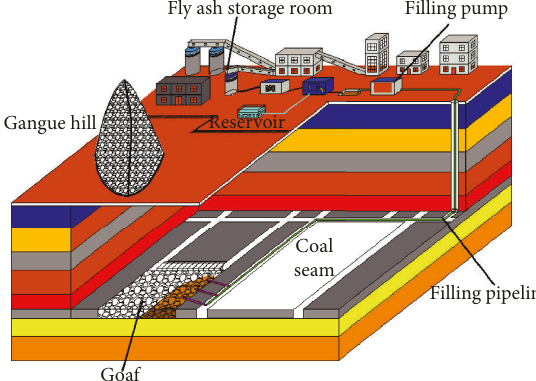
Figure 1: Schematic diagram of backfilling